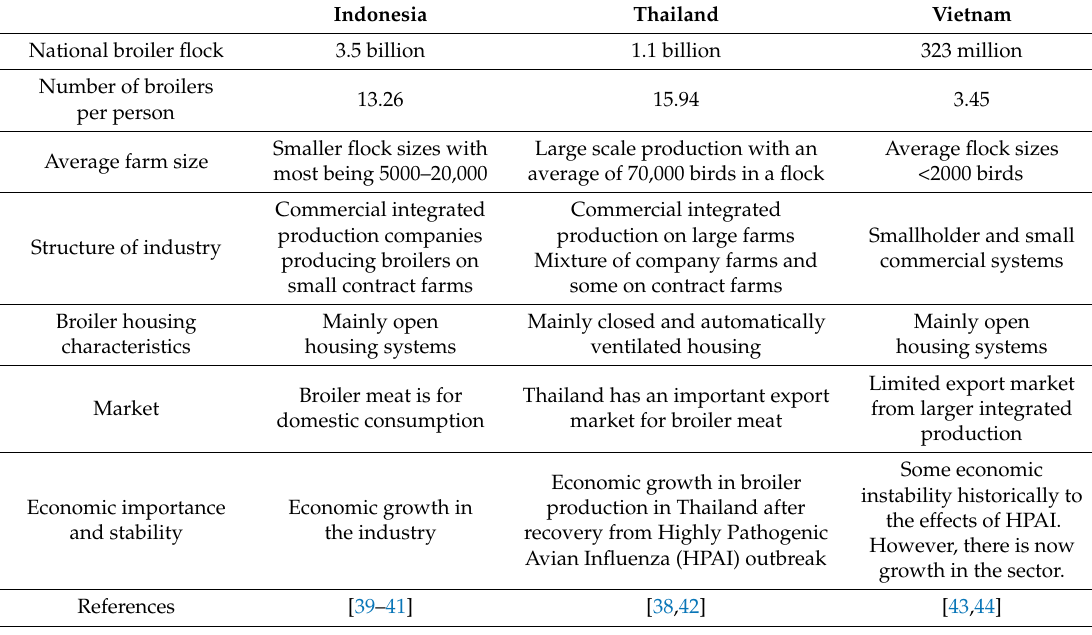
Table 4. An outline of the key characteristics of broiler production in Indonesia, Thailand, and